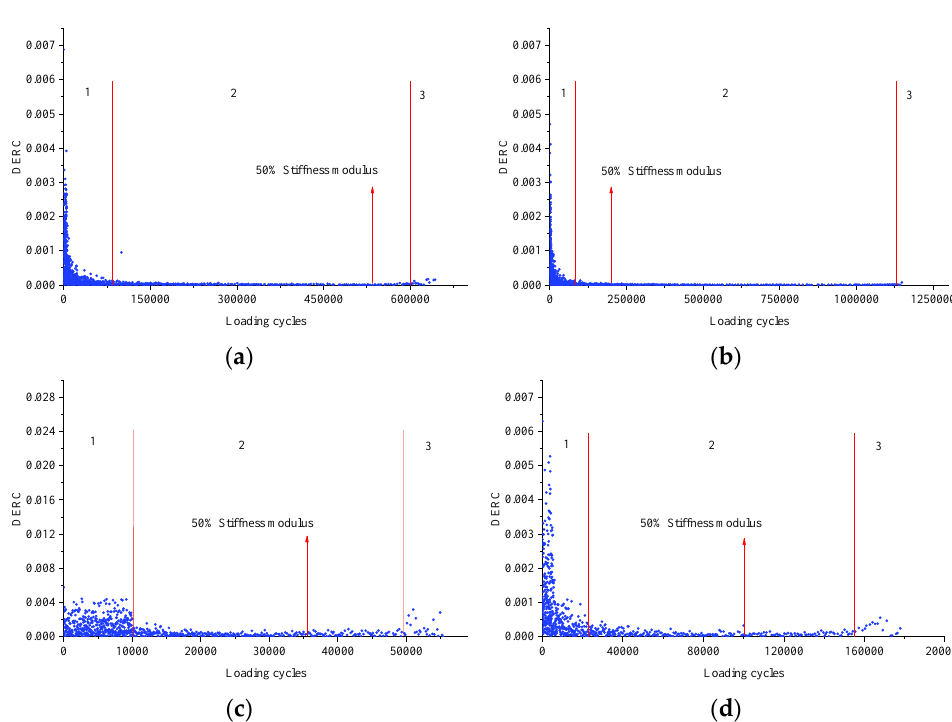
( f ) Figure 11. Change rate of dissipated energy: ( a ) SUP-20 (450 με) , ( b ) SUP-20 with BF (450 με) , ( c ) SUP-20 (650 με) , ( d ) SUP-20 with BF (650 με) , ( e ) SUP-20 (850 με) and ( f ) SUP-20 with BF (850 με) . 3.4. Further Analysis about the DERC Taking SMA-13 and SUP-20 with and without basalt fiber as examples, the four-point bending fatigue test was carried out under the strain of 850 με . The test terminated when the stiffness modulus decreased to 10% of the initial value. The results of the DERC are listed in Figure 12. The results showed that the stiffness modulus of the critical points in the second and third stages is much later than 50% of the initial value, which further